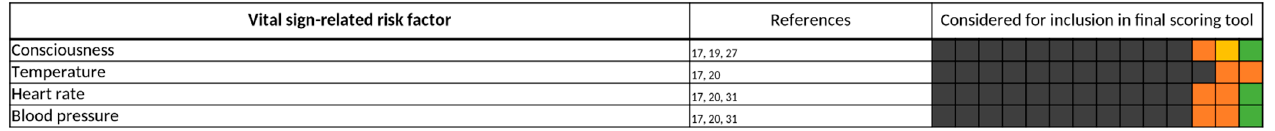
Figure 9. Vital sign-related risk factors. Each of the 14 boxes represents one of the included studies. The color of the boxes portrays whether a risk factor was not investigated in a study (gray), was investigated (orange), was significant in a first statistical analysis or based on expert consensus and therefore tested for inclusion in a final scoring tool (yellow), or whether a risk factor was included in a final scoring tool (green). The “citations”-column lists each study that at least investigated the respective risk factor.